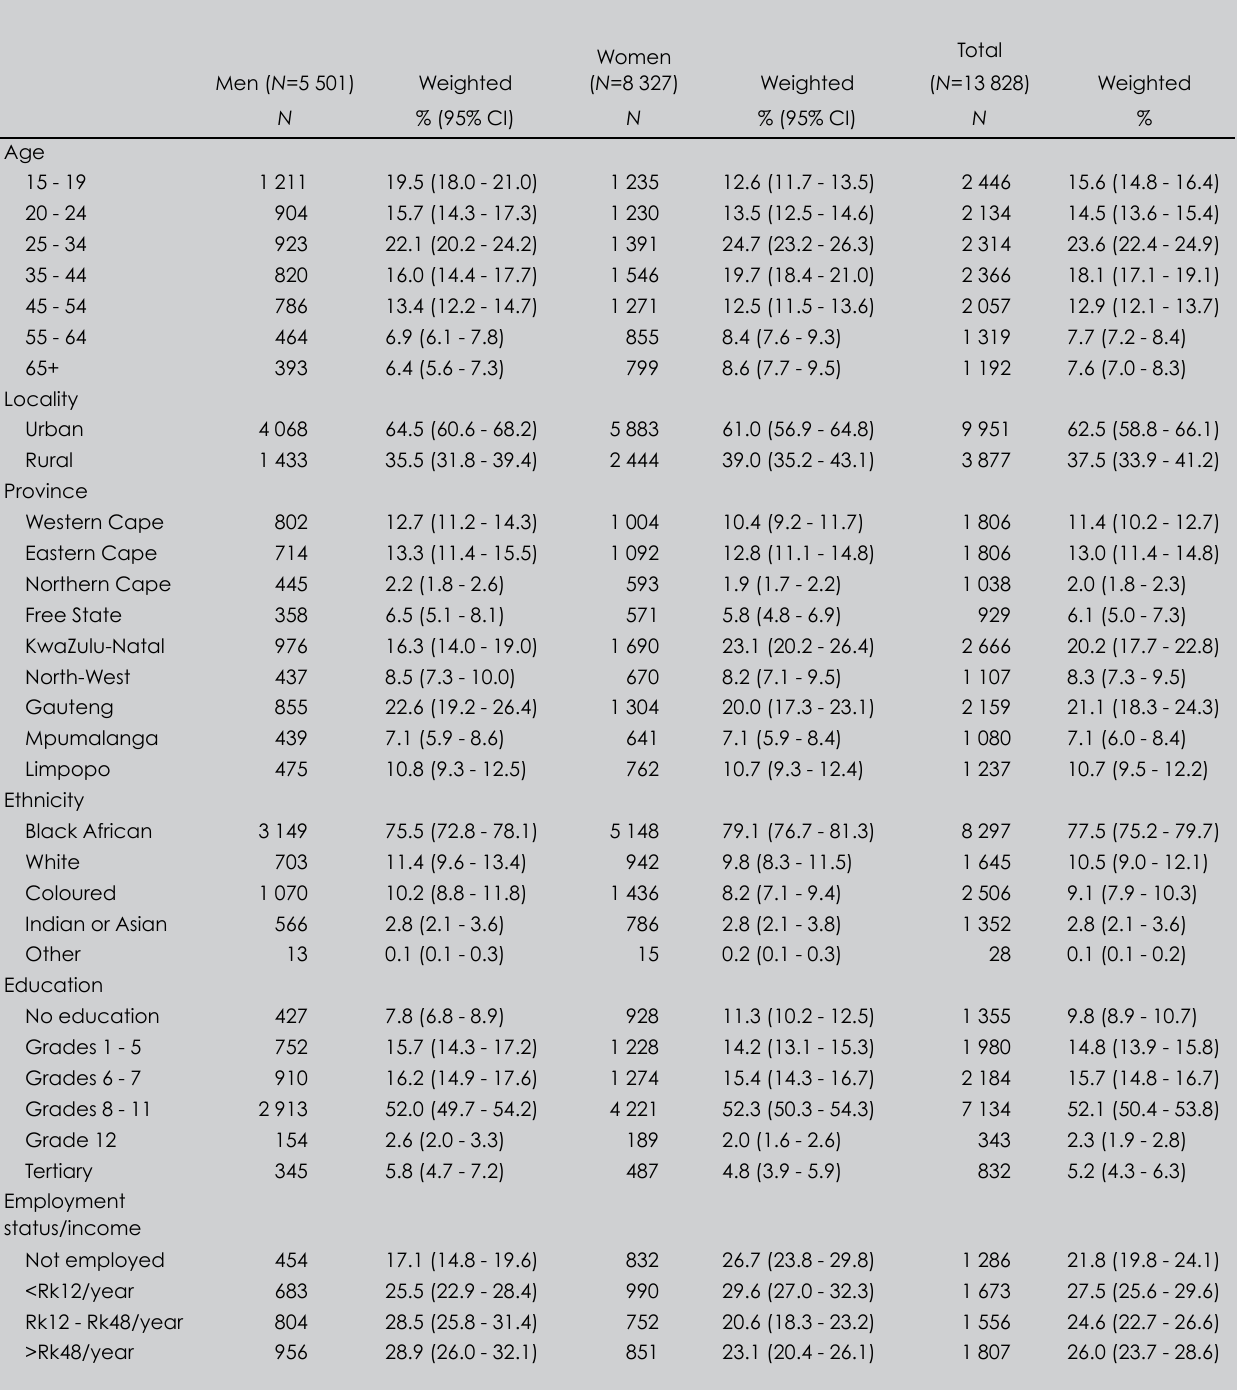
Table I. Demographic characteristics of respondents ≥15 years